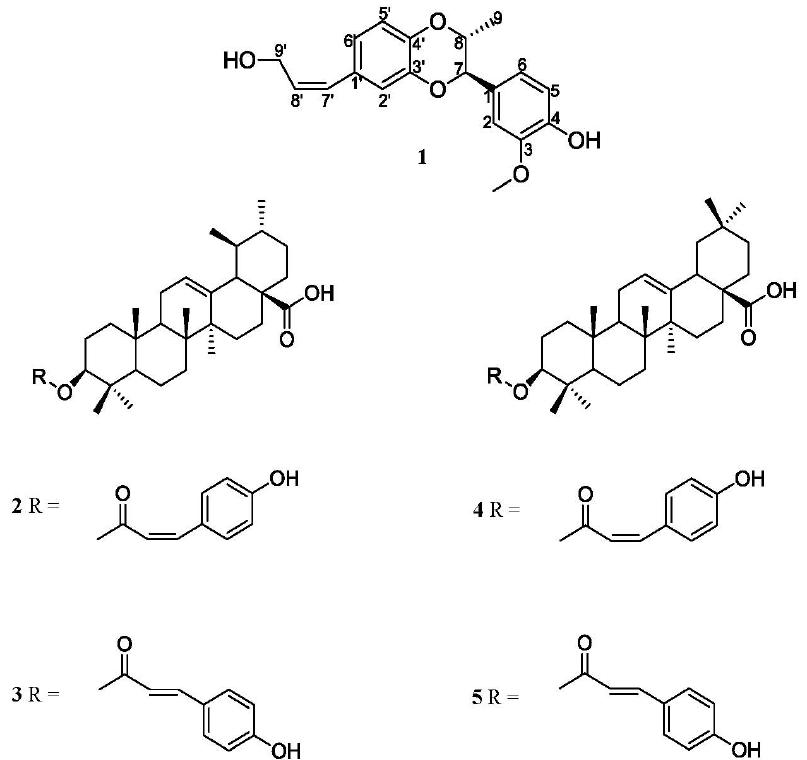
Figure 1. The chemical structures of compounds 1 – 5